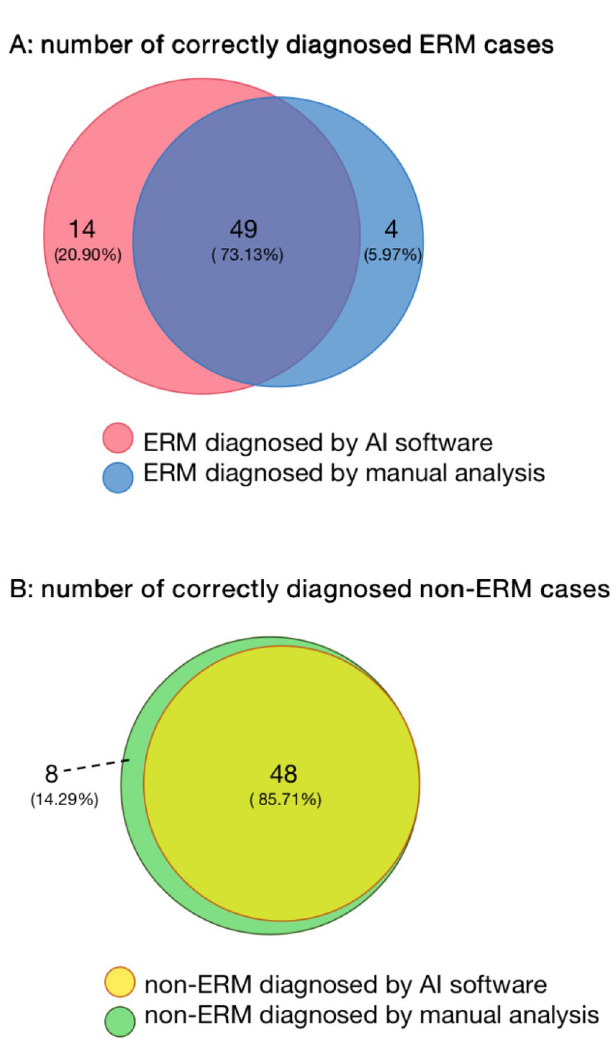
Figure 4. Correctly categorized ERM and non ERM by manual and AI